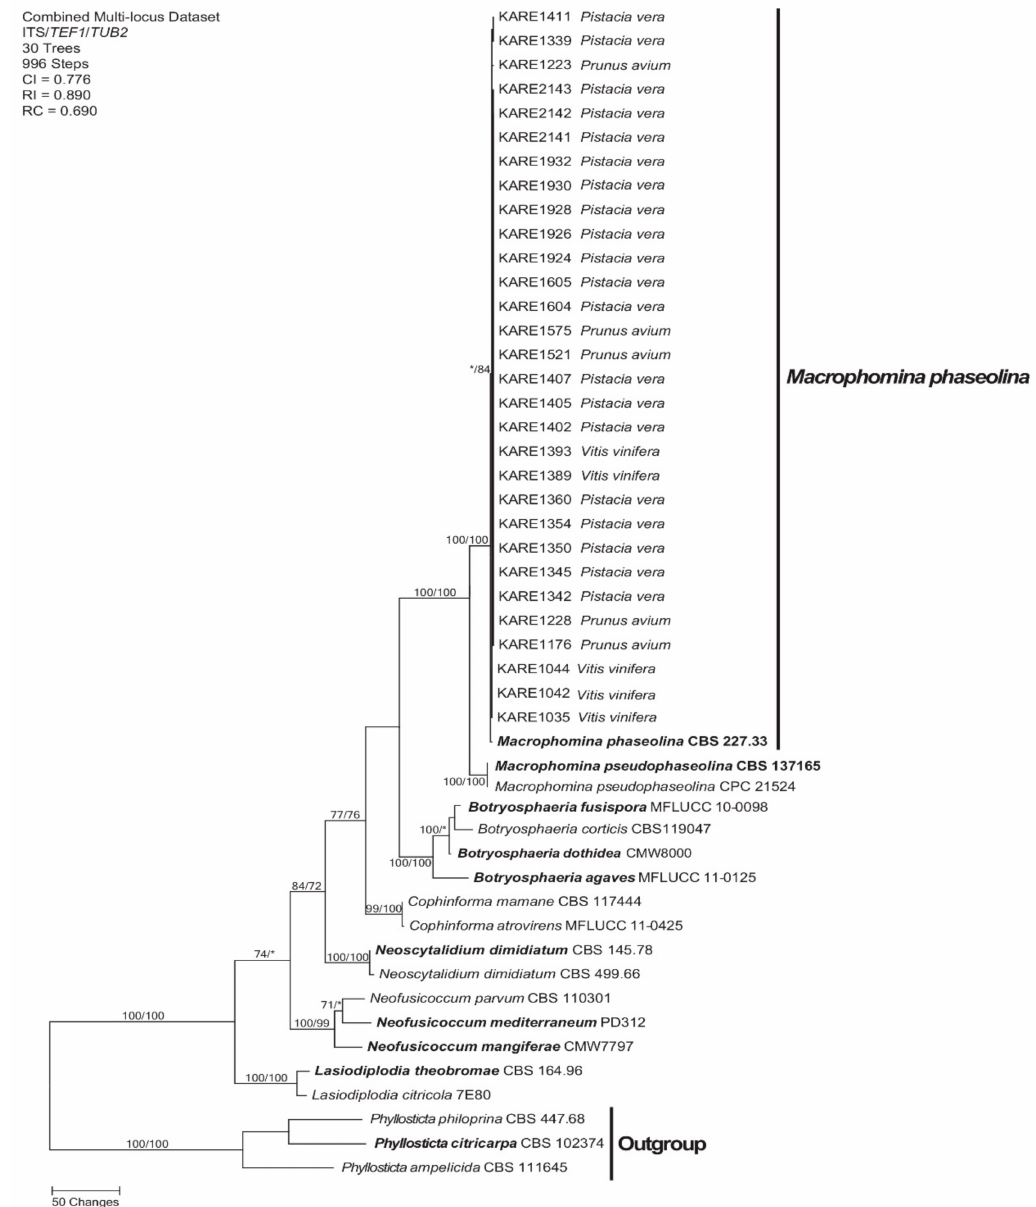
Figure 2. One of 30 equally most parsimonious trees resulting from the analysis of the three-gene combined dataset (ITS, TUB2 , and TEF1 ). Numbers in front and after the slash represent maximum parsimony and maximum likelihood bootstrap values, respectively. Values represented by an asterisk were less than 70%. Scale bar represents the number of nucleotide